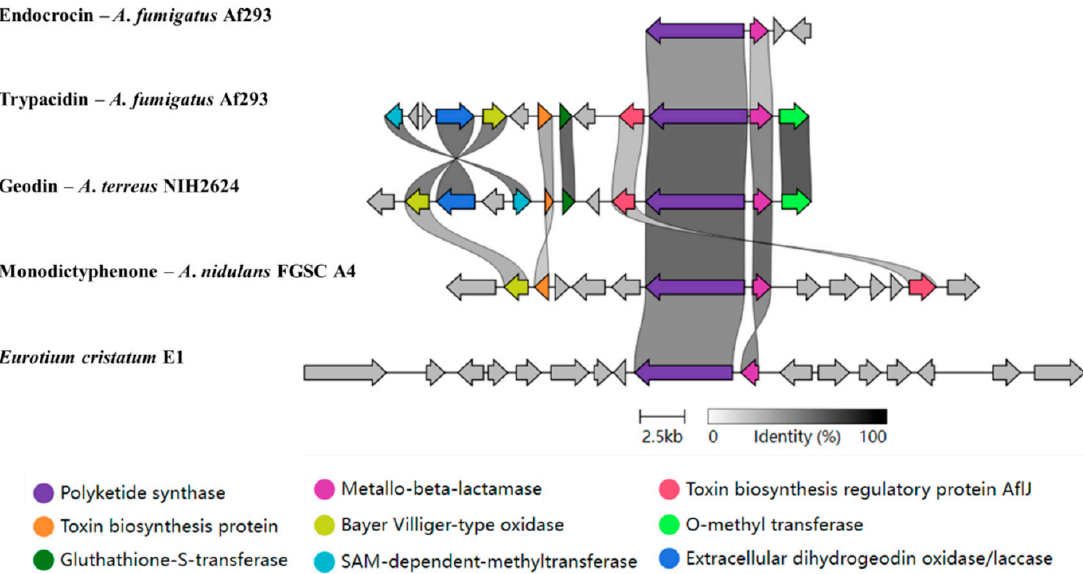
Figure 5. Comparison of emodin gene cluster in Eurotium cristatum E1 and other known species. The gene cluster used for comparison are from A . fumigatus Af293, A . terreus NIH2624, and A . nidulans FGSC A4, which have a complete emodin-related gene cluster. Each gene is indicated by an arrow. The homologous genes are shown in the same color, and other genes in gray. The genes of A2490 gene cluster in E . cristatum E1 from left to right: A2499 , A2498 , A2497 , A2495 , A2494 , A2493 , A2492 ,